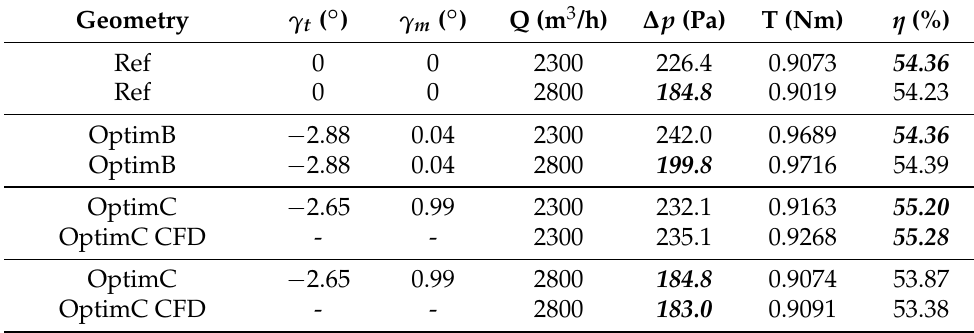
Table 2. Result of multi-objective optimization at two operating